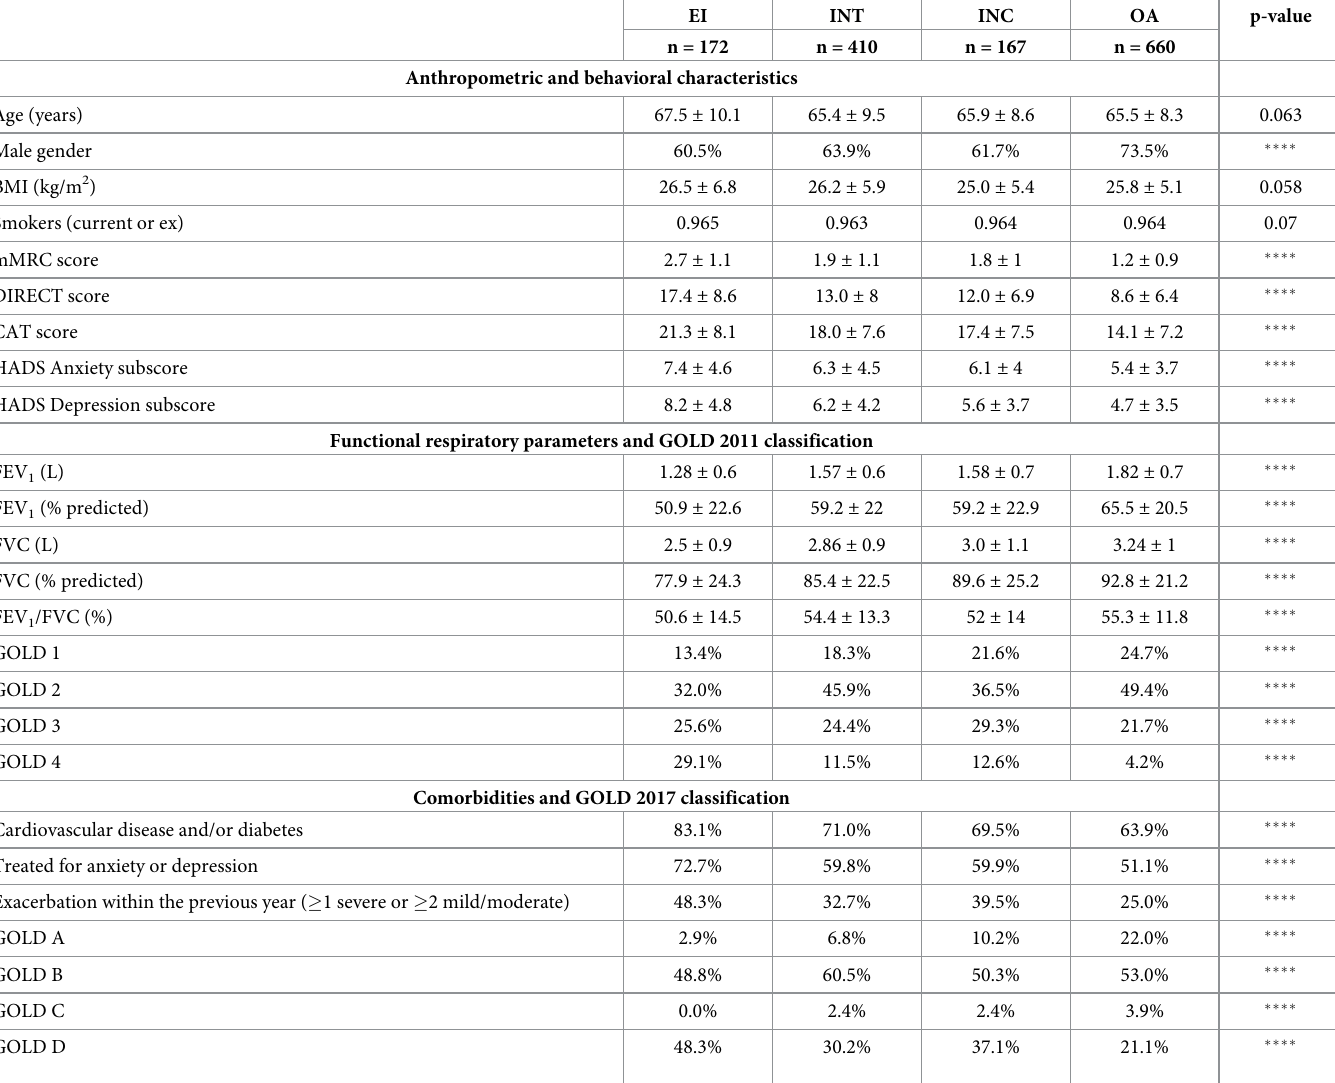
Table 2. Clinical and functional characteristics of the stratified COPD patients (n =